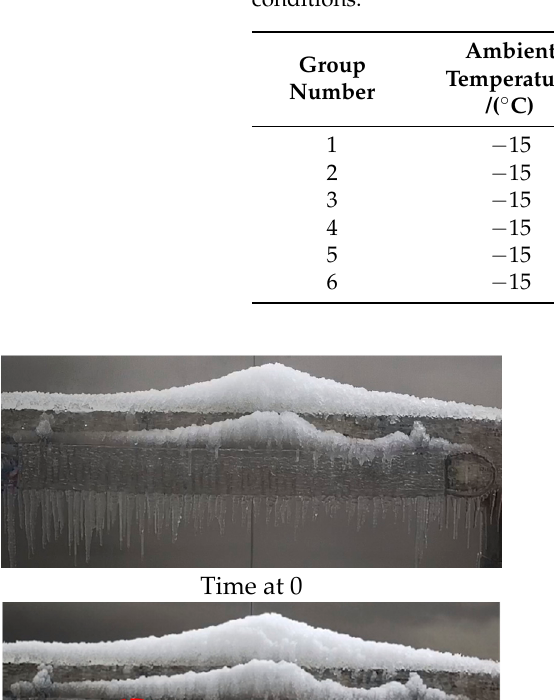
Table 5. The test conditions and the de-icing time period of passive de-icing tests under windy conditions.